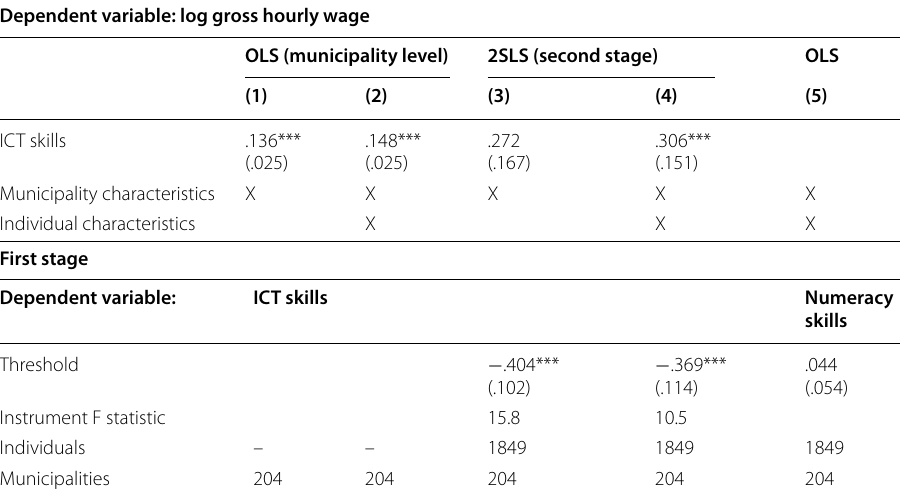
Table 4 Returns to ICT skills: instrumental‑variable models exploiting technological peculi‑ arities in broadband technology in West Germany. Source: adapted from Falck et al. (2016)